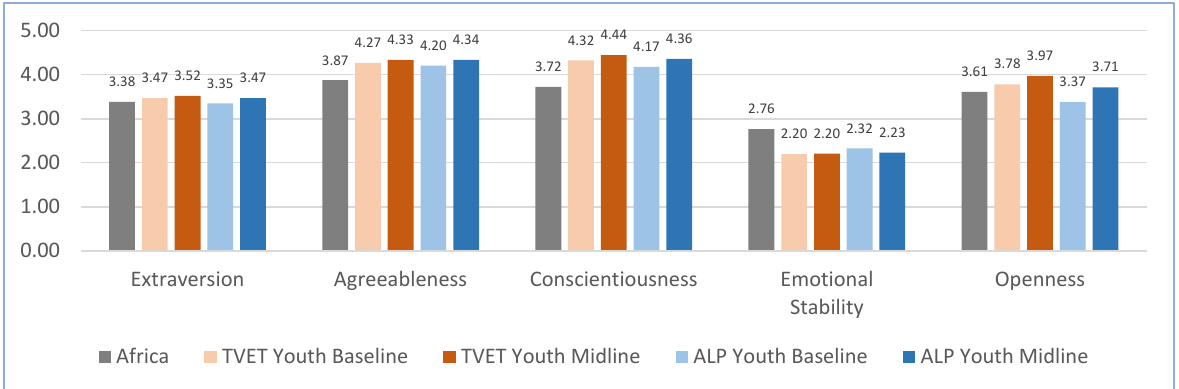
Figure 2. IYDA Youth Scores on Big Five Inventory